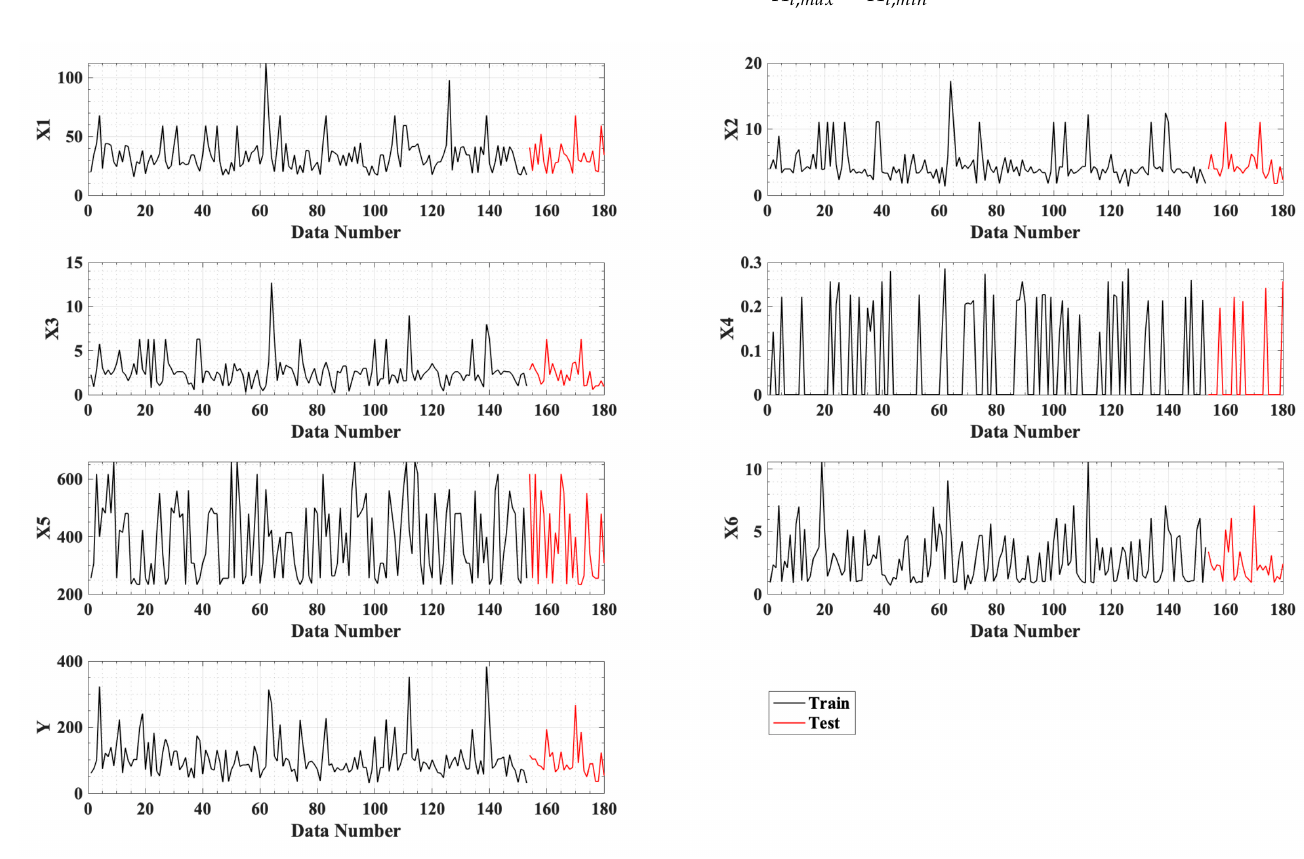
Figure 3. The values of the variables for each dataset.